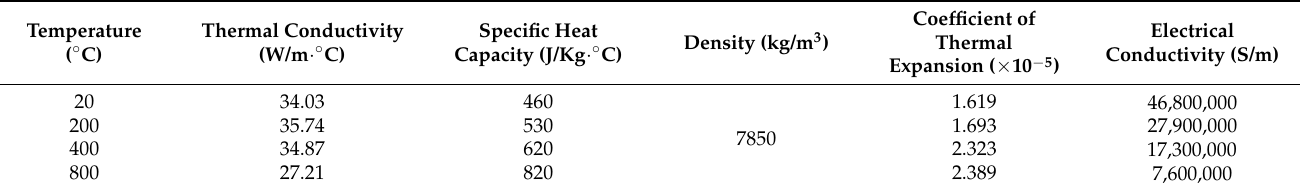
Table 2. Electrical and thermal properties of Cr12MoV [27].